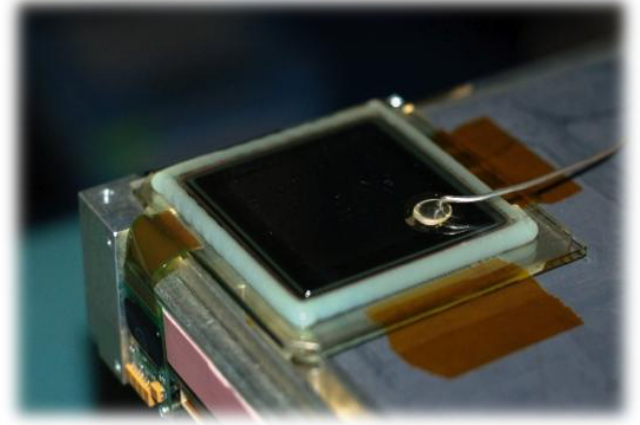
Figure 18. A direct conversion sensor based on coating a 64 × 64 pixel array with a-Se.